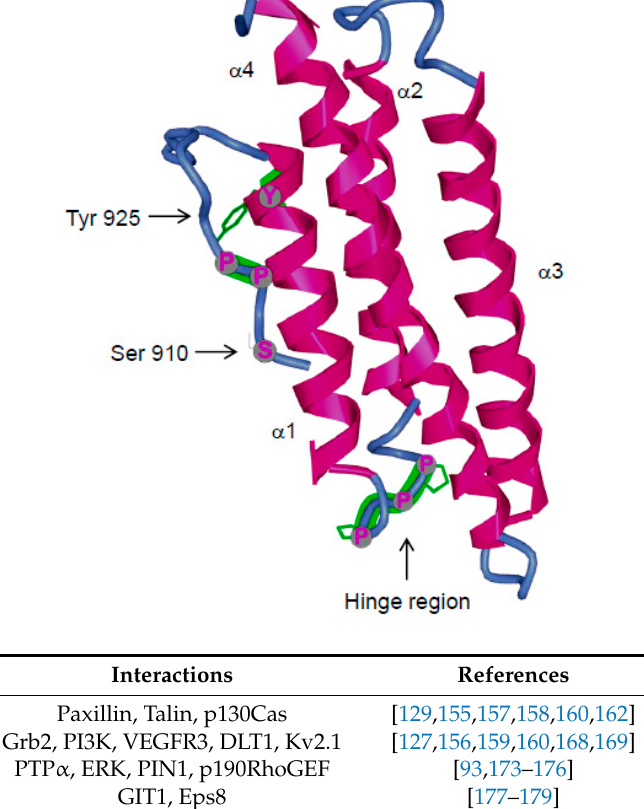
Figure 4. Structure of the FAT domain of FAK from the protein databank (accession code 3S9O). The FAT domain is a four-helix bundle composed of helix α 1, α 2, α 3 and α 4. The hydrophobic patches HP1 and HP2 important for paxillin binding are located at the interface of helix α 1– α 4 and α 2– α 3. Tyr925 and Ser910 are highlighted. The residues of the hinge domain located between helix α 1 and α 2 important for FAK dimerization and phosphorylation of Tyr925 are coloured in green. Proteins associating with the FAT domain are shown in the table.